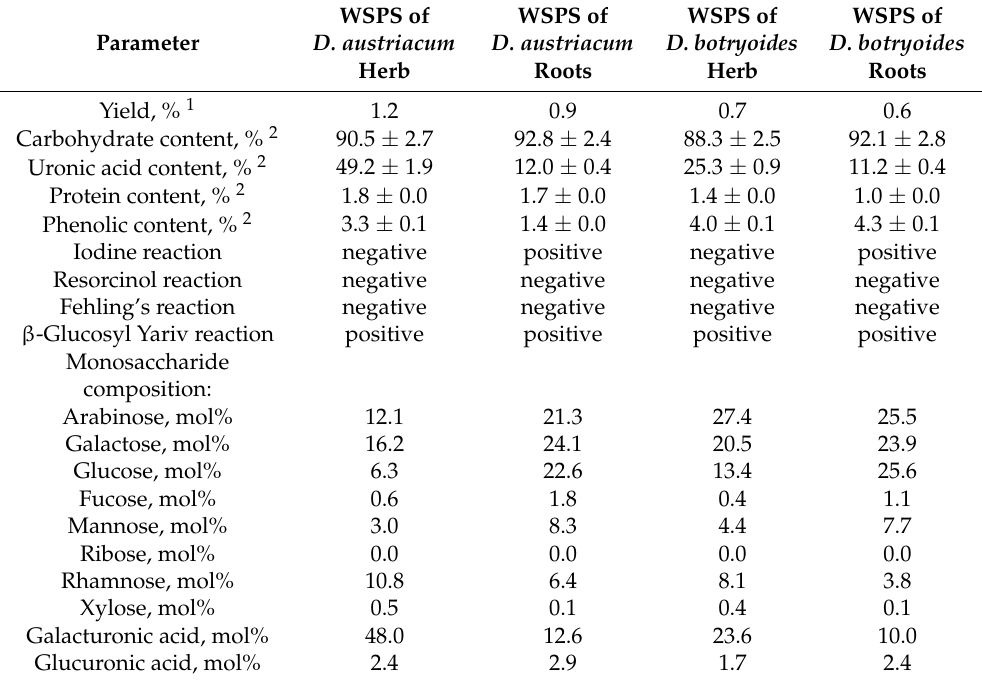
1 Percentage of dry plant weight. 2 Percentage of polysaccharide fraction